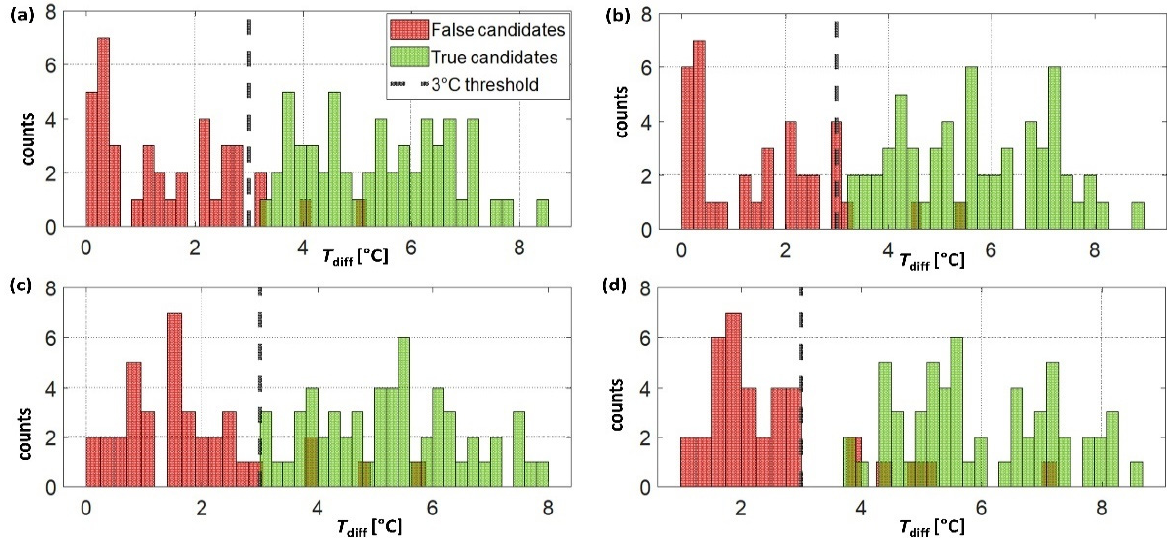
Figure 5. Distribution of the differences in temperature around the potential non-wear candidates for the four options of the event- and temperature-based algorithm. The red histograms are related to false and the green to true non-wear events. The dashed, vertical black line indicates 3 °C. The distributions were computed using the training data (five participants). In option 1 ( a ), option 2 ( b ), and option 3 ( c ), the candidates were discriminated based on the averages over the window spanning either the entire period between candidates, the period in the middle, or a 60 min interval, respectively, whereas in option 4 ( d ), averages were computed on a 5 min window around a local minimum/maximum.